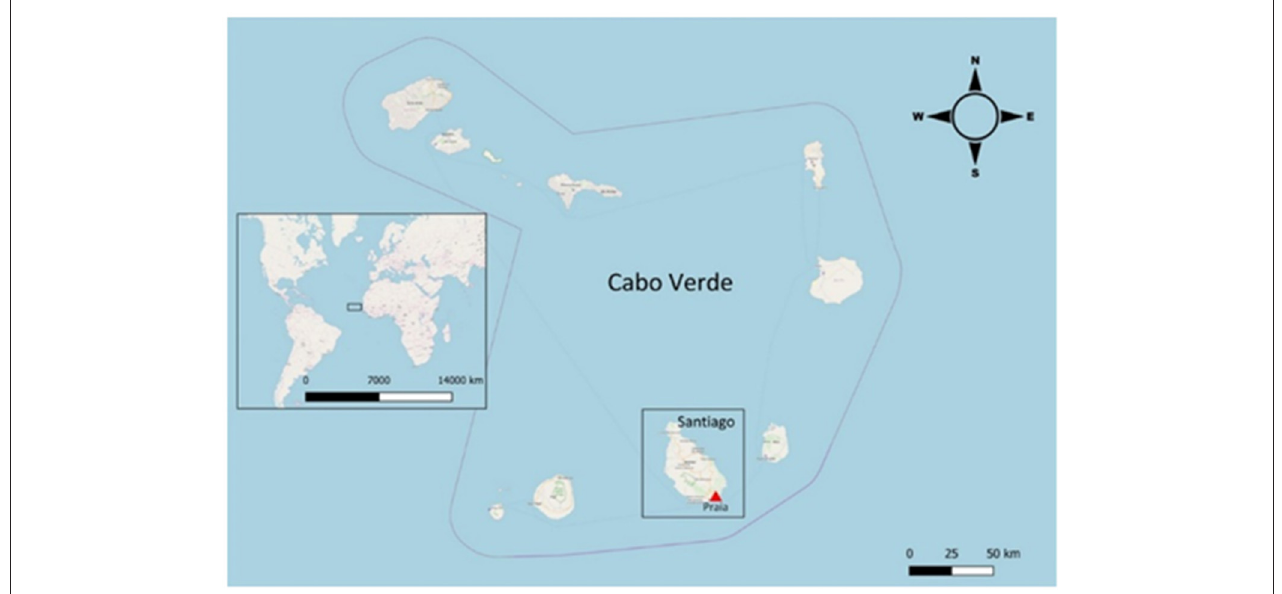
FIGURE 1 | Location of Praia in Santiago Island (Cabo Verde). Map modified with QGIS 3.8.0-Zanzibar (www.qgis.org) from OpenStreetMap.org. OpenStreetMap® is open data, licensed under the Open Data Commons Open Database License (ODbL) by the OpenStreetMap Foundation